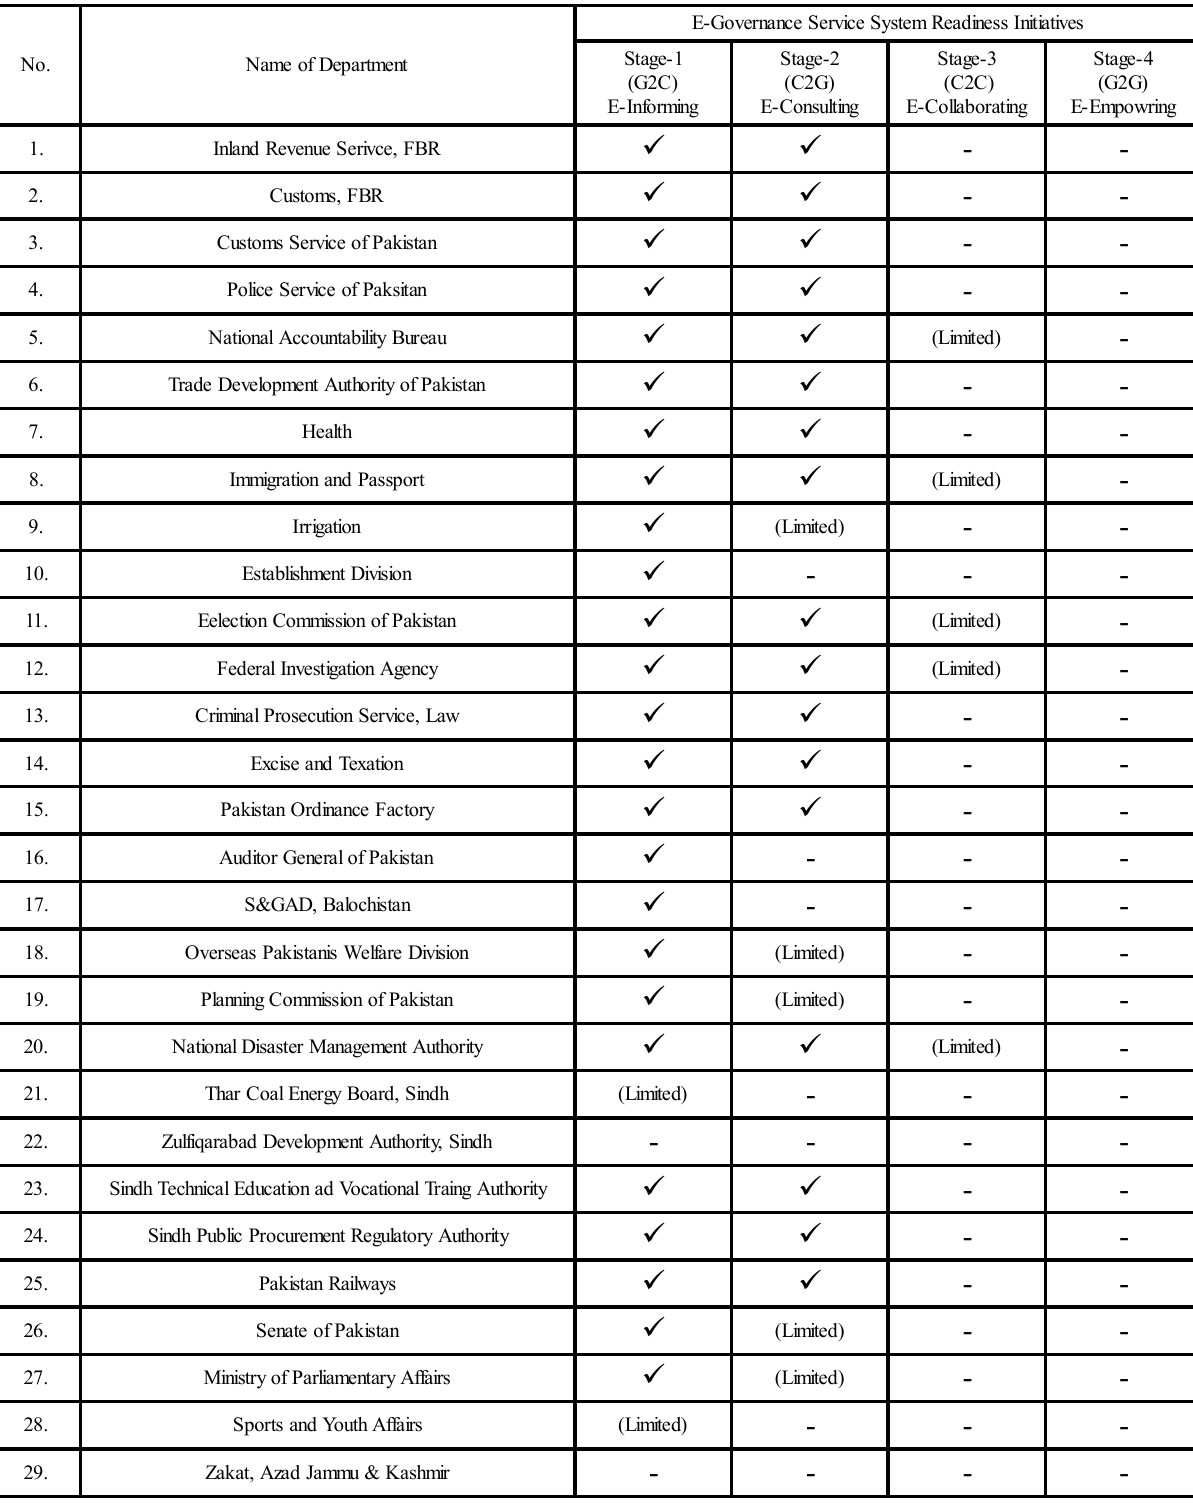
TABLE 1. E-GOVERNANCE SERVICE SYSTEM READINESS INITIATIVES IN GOVT. DEPARTMENTS OF